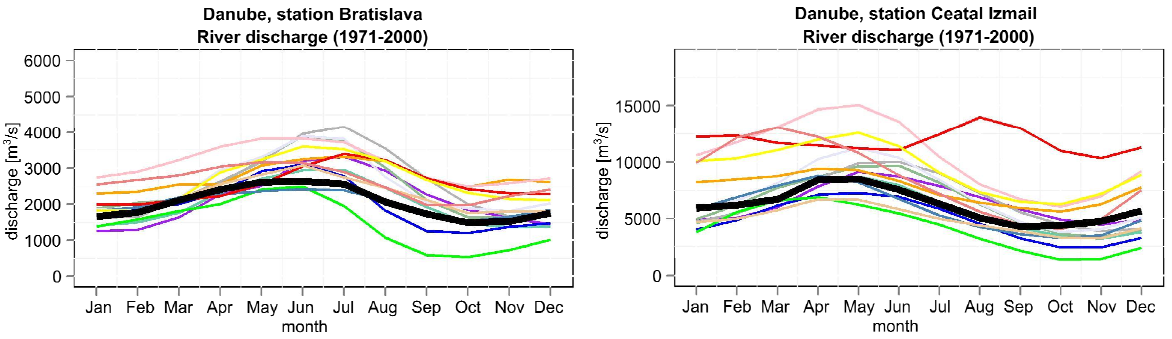
Figure 5. Comparison for the years 1971–2000 of simulated river discharge with ENSEMBLES [21] RCM data with historic observations for the Danube station Bratislava (Upper Danube basin) and the Danube station Ceatal Izmail at the Danube Delta. The thick black line shows the measured